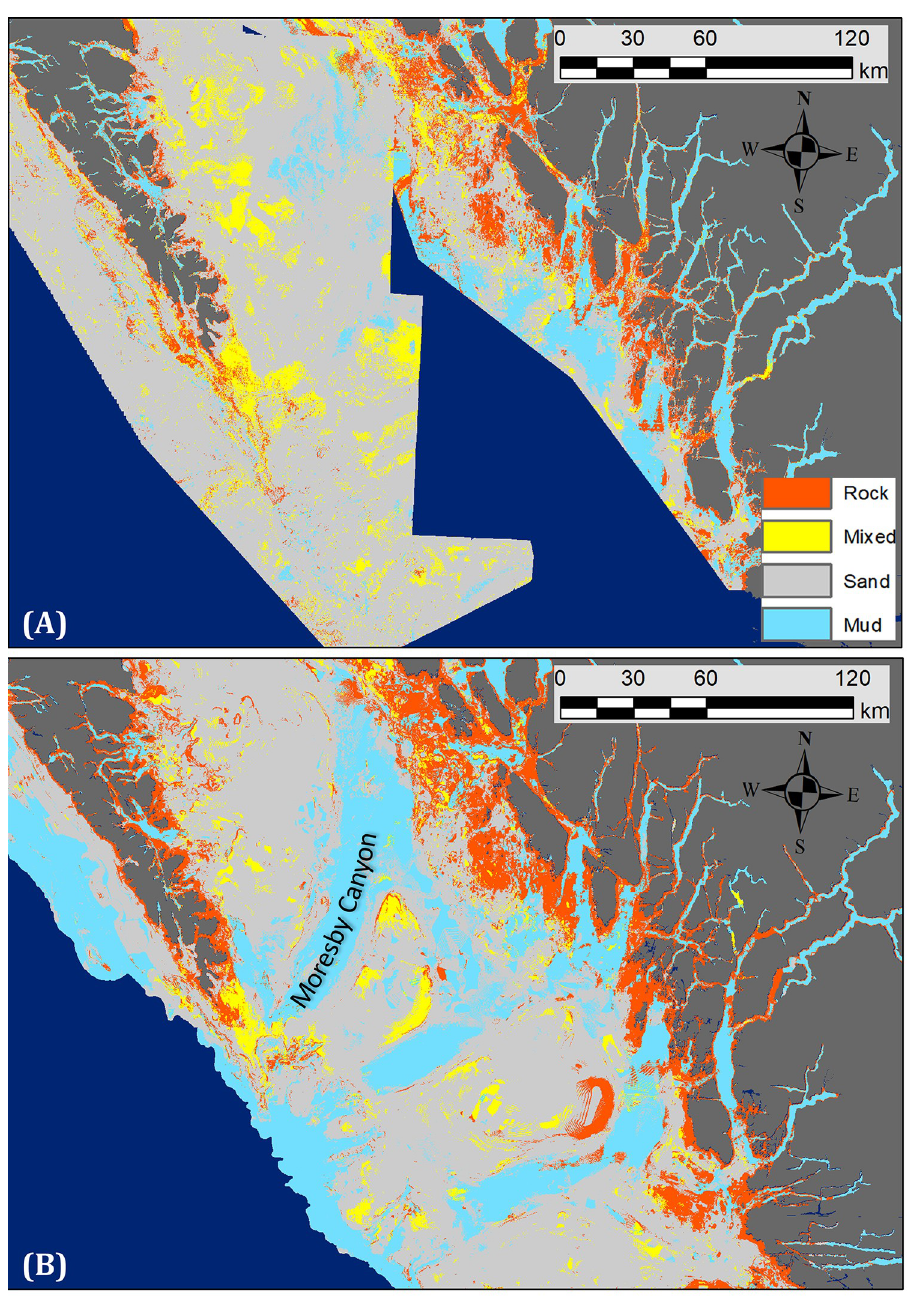
Fig 8. Mapped predictions for different resolutions. Predictions for portions of the HG and NCC 20 m regional models (A) are shown for comparison with the 100 m coastwide model (B). Note the detail provided by the 20 m models near shore where the 100 m model predicts largely Rock. In contrast, the 100 m model identifies known features at depth (e.g., Moresby Canyon) not captured by the 20 m models. The regional models are shown using unclipped predictor variables to allow model comparison in deeper waters. See text for